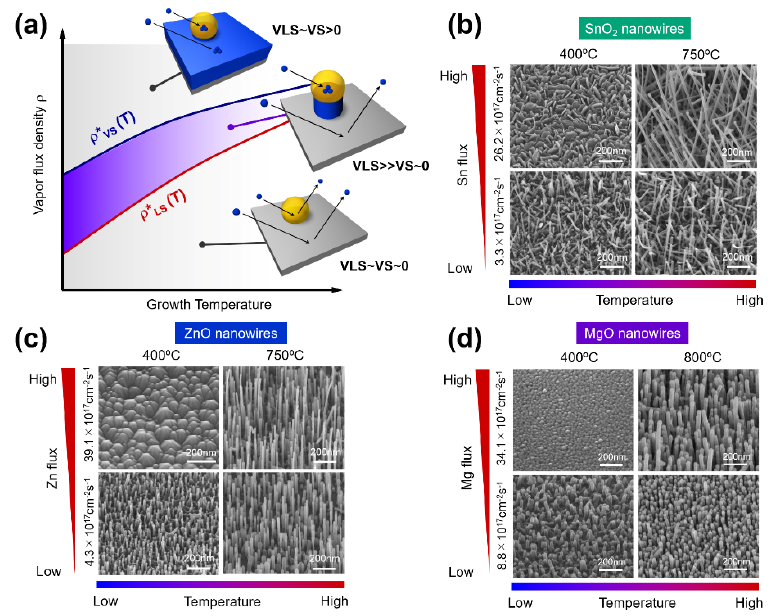
Figure 3. ( a ) The concept of “materials flux window” for nanowire growth (VLS, Vapor–Liquid–Solid; VS, Vapor–Solid); SEM image of ( b ) SnO 2 nanowires; ( c ) ZnO nanowires; and ( d ) MgO nanowires fabricated under the guidance of ‘materials flux window’. Reprinted from reference [83] with permission from the American Chemical Society.